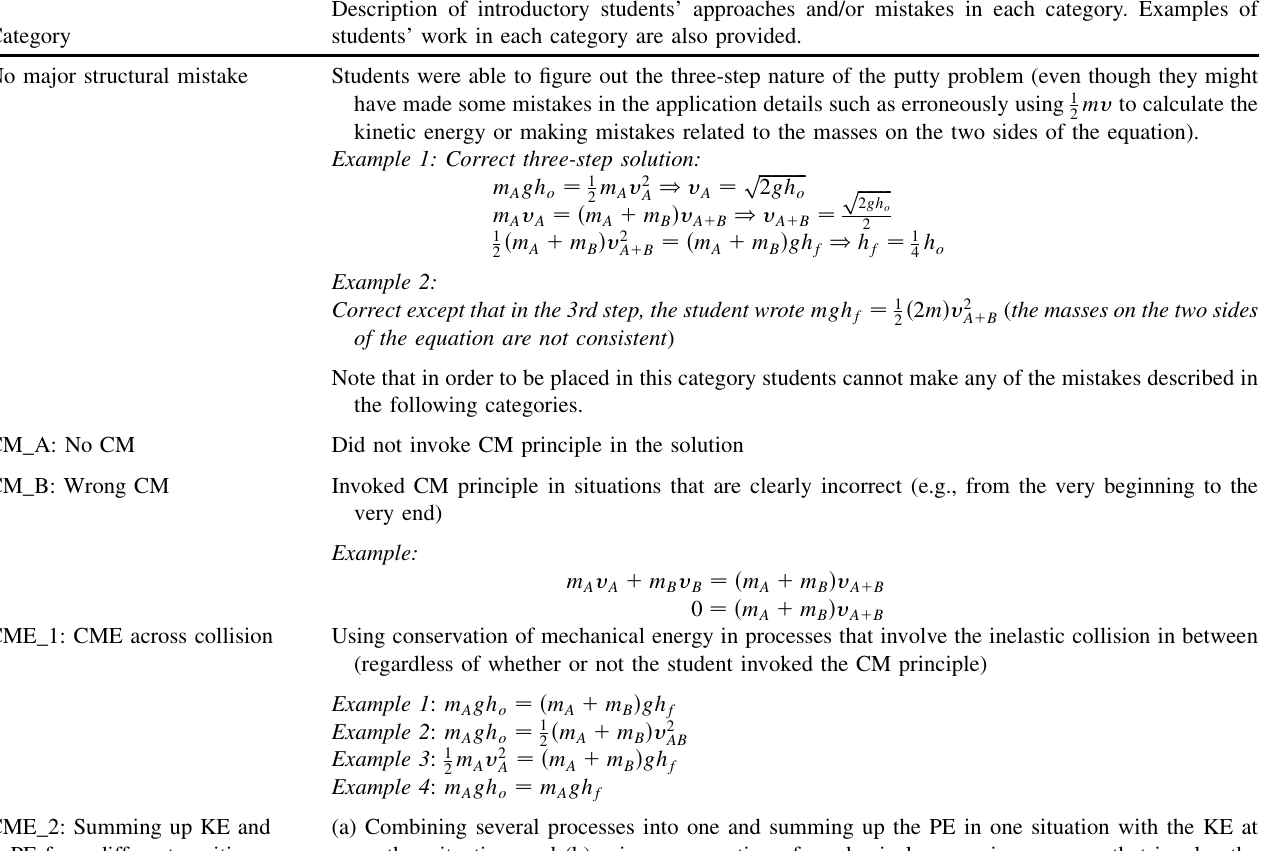
TABLE XI. Common student approaches to and/or mistakes made in the quiz problem. Description of introductory students’ approaches and/or mistakes in each category. Examples of students’ work in each category are also